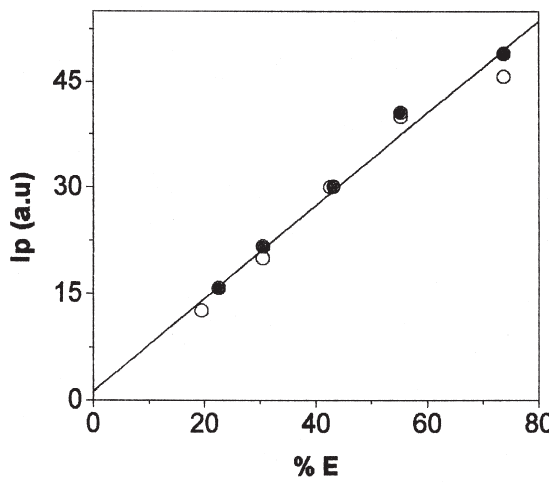
F IG . 5. – Plot of initial intensity of the O nal (Ip) as a function of the absorbed laser energy (%E) for differ- ent LiCl concentrations. ( m ): in the absence of salt; ( l ) in the pres- ence of LiCl 0.1 M. Sensitizer RB, Abs